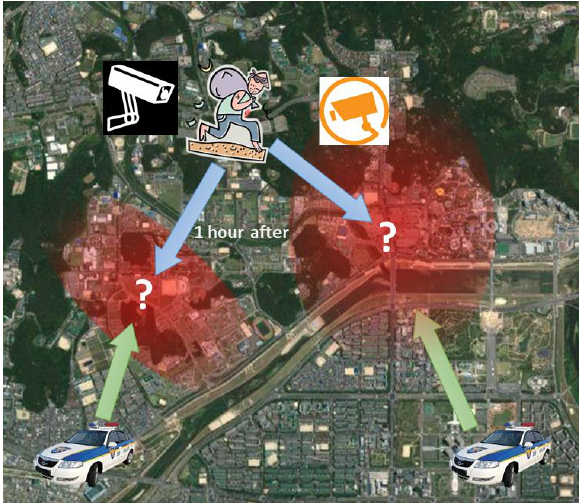
Figure 4. A use case for arrest of a criminal suspect by the collaboration of unmanned patrol cars and